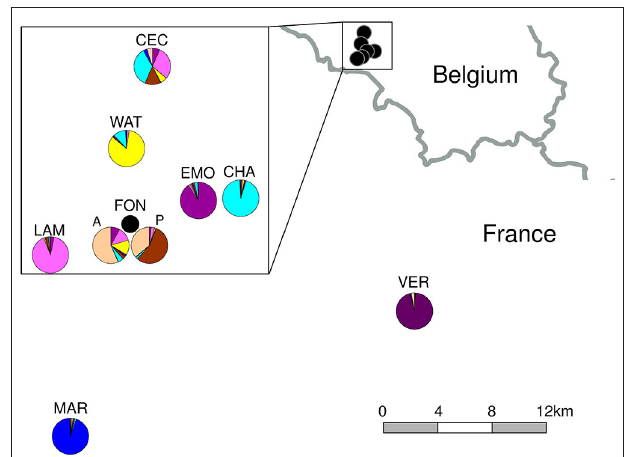
Supplementary Table S1 . The pie charts correspond to mean membership values at K = 8 clusters for the adult generation (except for FON: A, adults and P, seed progeny) of the structure analysis ( Figure 2